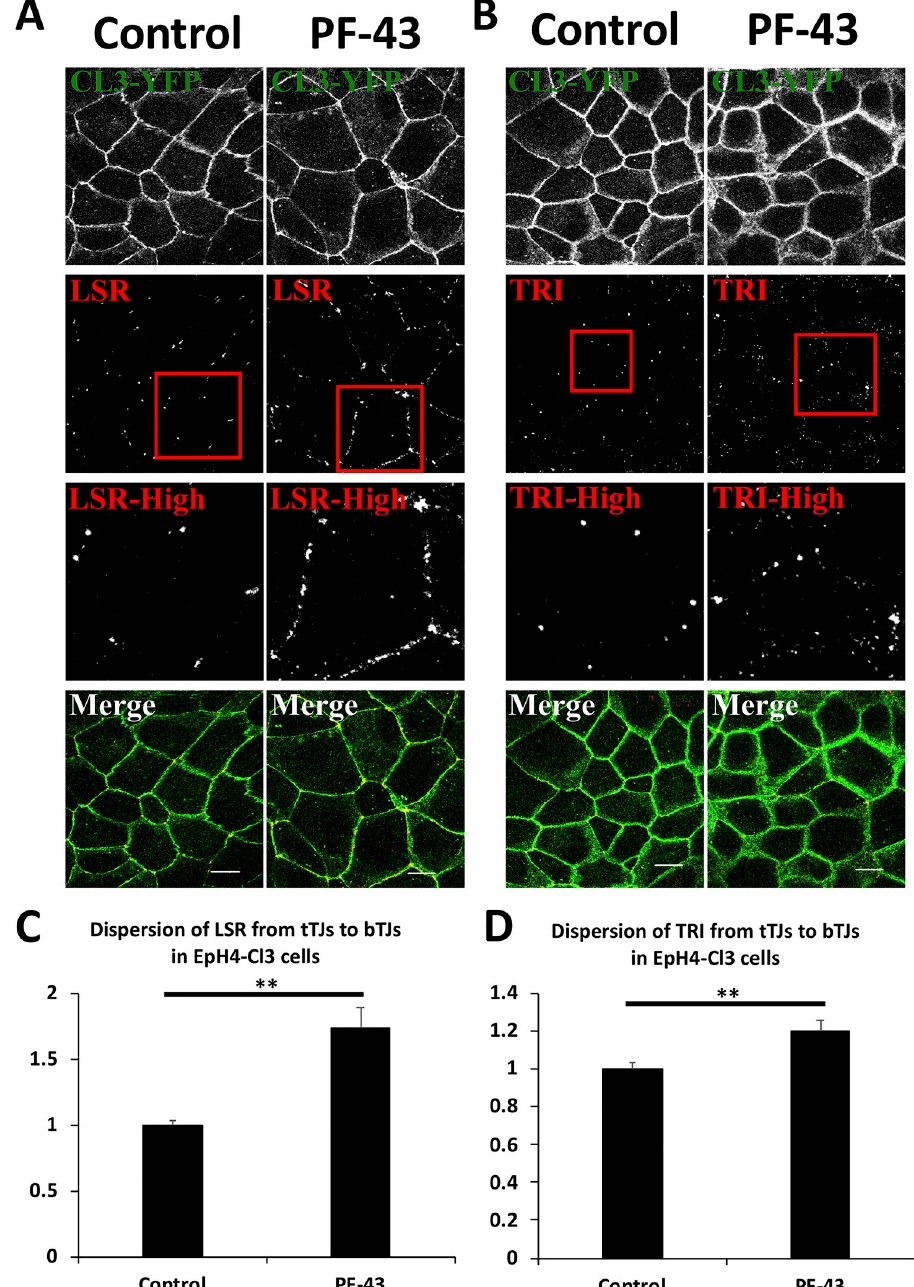
Fig 1. Subcellular localization of tTJ proteins in PF-43-treated EpH4-Cl3 cells. EpH4-Cl3 cells were incubated with DMSO (Control) or 20 μ M PF-43 for 120 min. The cells were then immunostained with anti-LSR (A) and anti- tricellulin (B, TRI) antibodies, and observed using confocal microscopy. The red rectangular regions represent higher magnifications (LSR-High and TRI-High). Merge represents the merged image. Scale bar = 10 μ m. Dispersion of LSR (C) and TRI (D) in Control or 20 μ M PF-43 treated cells was calculated, and the means and the SEMs are shown in the graph ( n = 30, �� p < 0.01). The dispersion values in control cells were set to